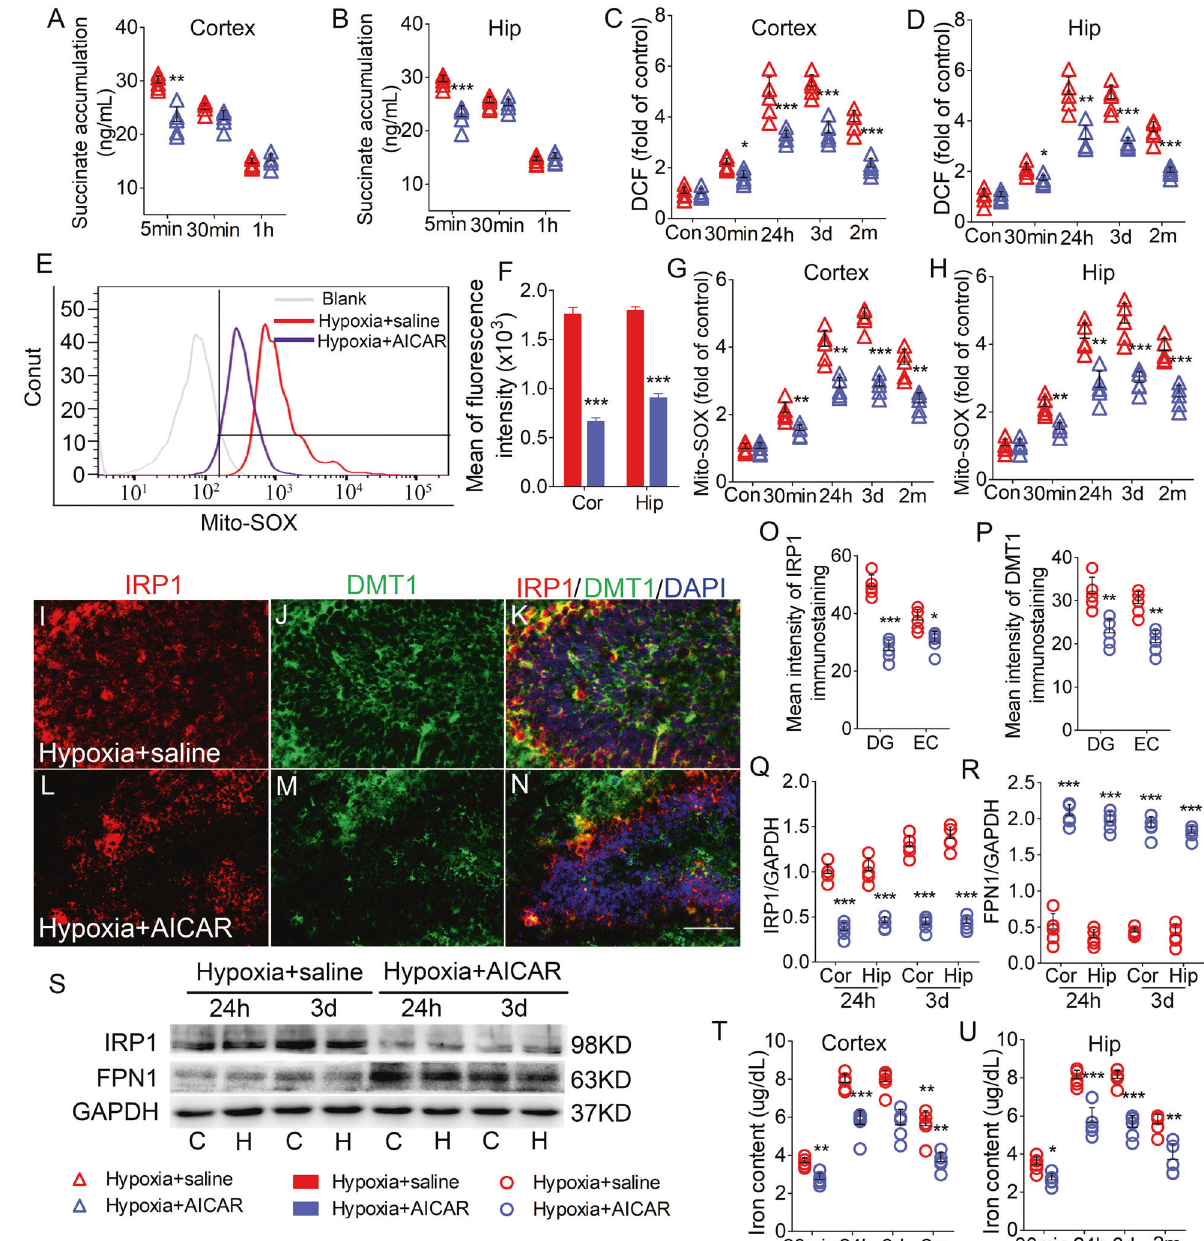
Fig. 7 AICAR attenuated the succinate accumulation, oxidative stress, and iron stress induced by hypoxia treatment. Decreased levels of ( A , B ) succinate, ( C , D ) DCF, and ( G , H ) mito-SOX in the cortex and hippocampus due to AICAR treatment. E , F Flow cytometry-based quanti fi cation of hippocampal mito-SOX signal. I – N Decreased immunoreactivity of IRP1 (red) and DMT1 (green) in the DG region after AICAR treatment Blue, DAPI. O , P Quanti fi ed changes of IRP1 and DMT1 in the EC and DG. Bar = 50 μ m. Q – S Expression of IRP1 and FPN1 in the hippocampus and the cortex estimated using western blotting. n = 5/group. T , U Levels of iron ( n = 5 per time point). * P < 0.05, ** P < 0.01, and *** P < 0.001, all compared with hypoxia + saline group (One-way ANOVA). injury. Accordingly, succinate accumulation may contribute to Epilepsy is a common brain disease, which ranks second neonatal hypoxia-induced epilepsy. This requires further after stroke in the nervous system [68, 69]. Epileptic seizures experimental research. often occur in the neonatal period, with an incidence of In summary, we observed succinate accumulation in the 3 – 5% among live births [70]. Additionally, their most common early period after neonatal hypoxia administration. Moreover, cause is hypoxic-ischemic encephalopathy. Severe oxidative succinate accumulation is crucial for initiating oxidative stress stress, with mitochondrial dysfunction and neuronal damage, is and iron stress. Reversing early succinate accumulation may a vital characteristic of epilepsy [9]. Our fi ndings con fi rmed that attenuate oxidative stress and iron stress and mitigate early succinate accumulation may be a critical initiator of neuronal damage and cognitive defects. This study provides neonatal hypoxia-induced oxidative stress and neuronal